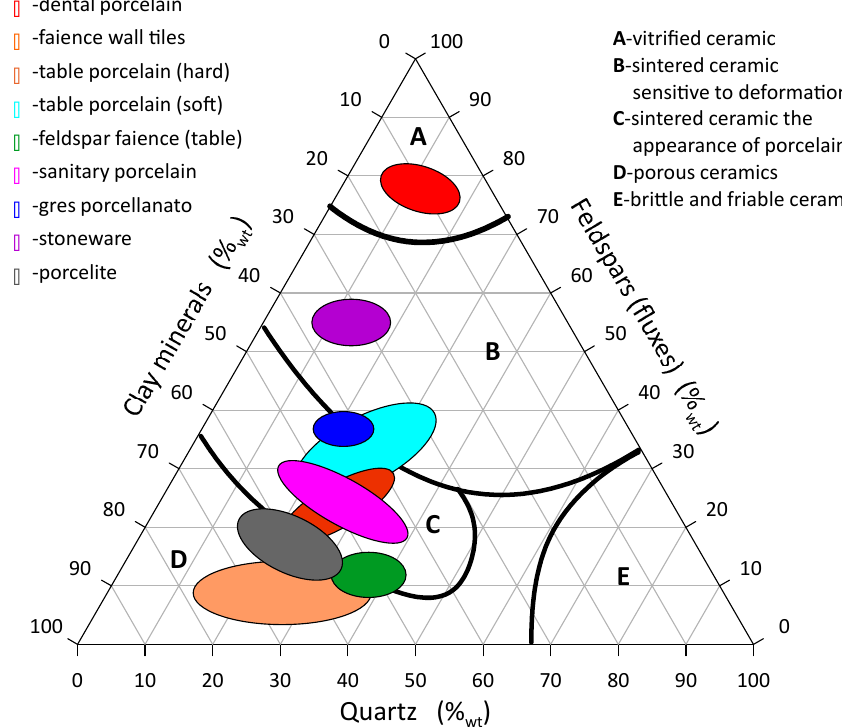
Figure 1. Diagram of typical rational compositions of ceramic masses.